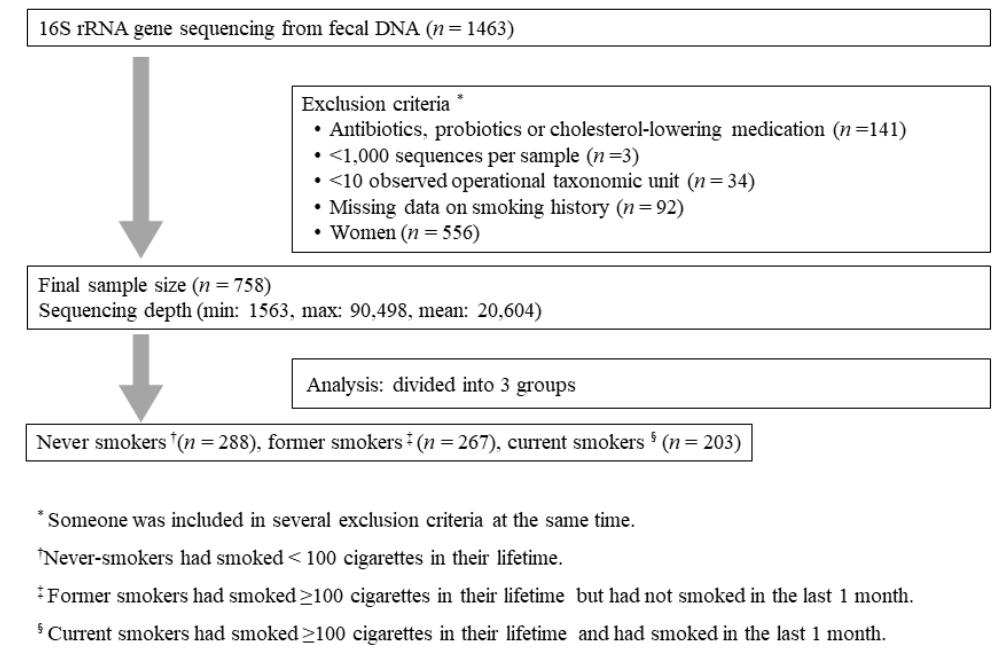
Figure 1. Flow of Figure 1. Flow of study.